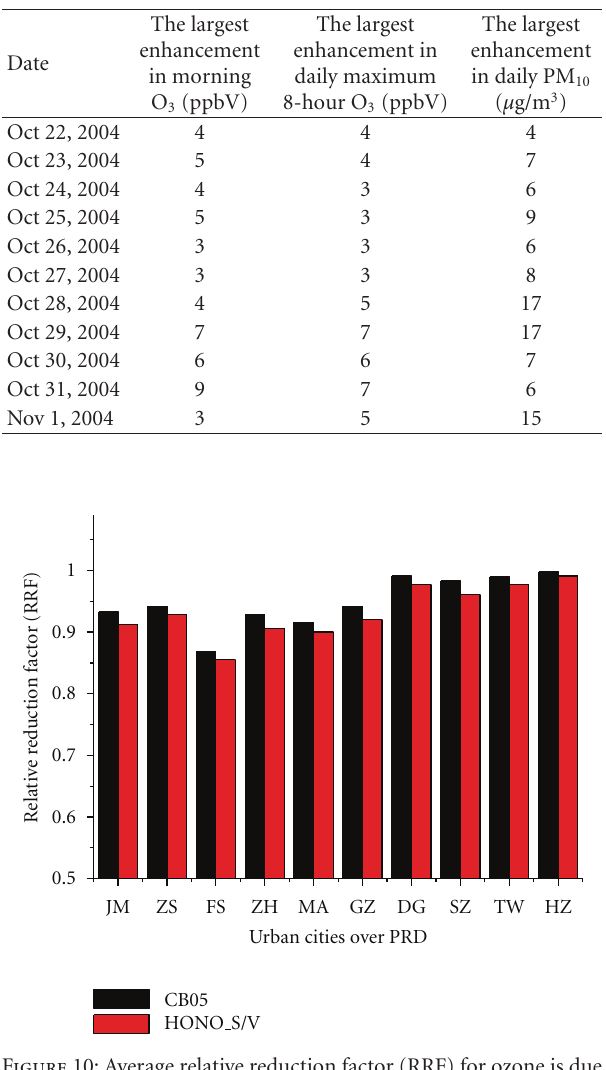
Table 3: The largest enhancement in morning (8 am—noon) O 3 , daily maximum O 3 , and daily mean PM 2 . 5 in the modeling domain due the additional HONO sources (case HONO S/V subtract case CB05).